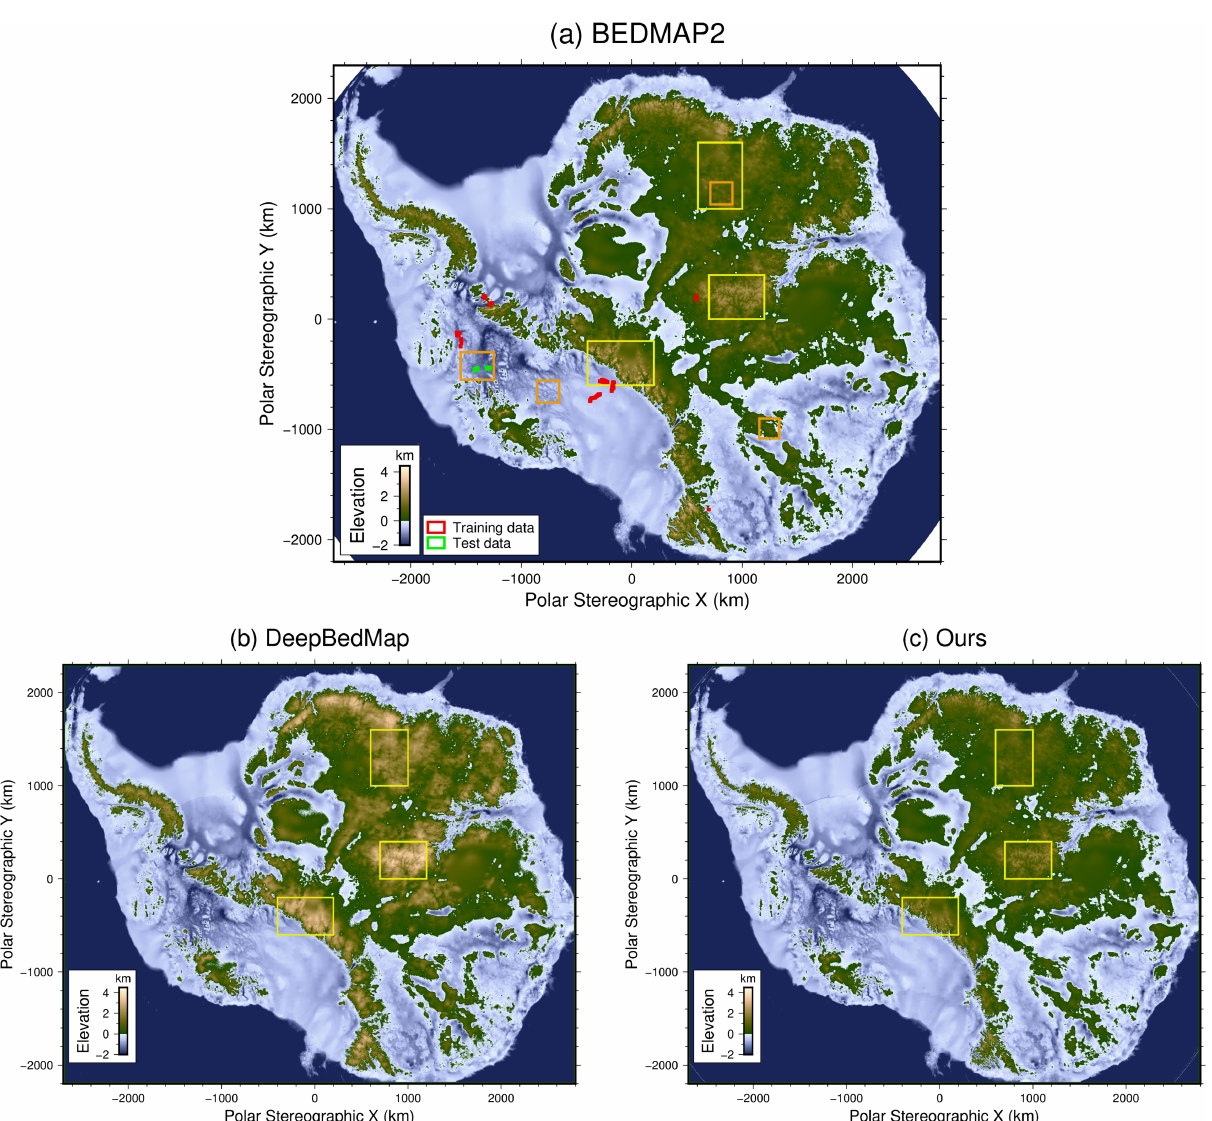
Figure 4. The whole Antarctic continent DEM comparisons of bed topography with BEDMAP2, DeepBedMap [17], and MB_DeepBedMap. Red areas show locations of training data. Green areas show locations of test data. Orange boxes show locations of test regions. Yellow boxes show locations of the obvious differences between the above